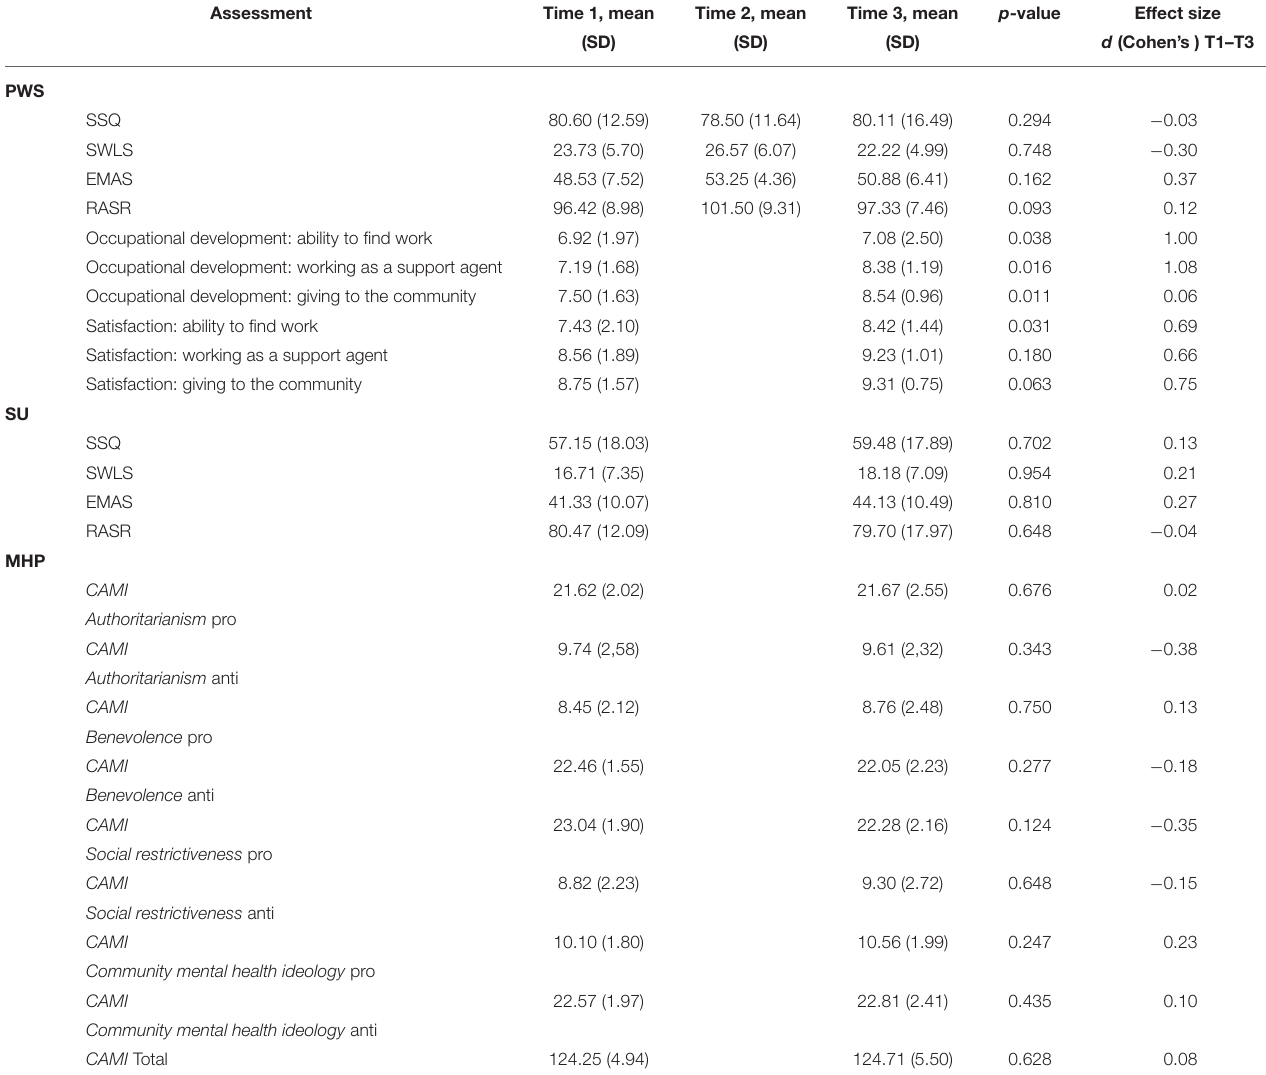
TABLE 6 | Results grouped according to levels of